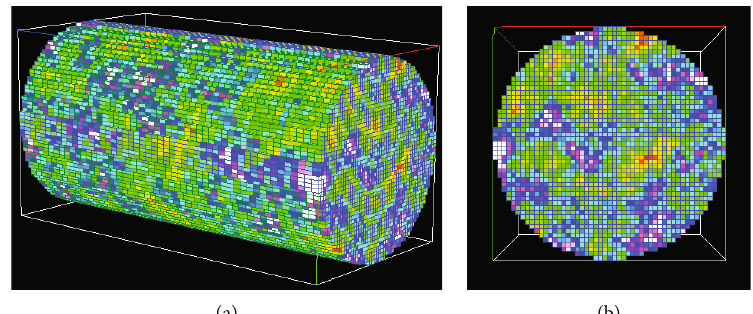
Figure 6: Numerical simulation of cores from di ff erent perspectives. (a) Numerical simulation of core under head-up view. (b) Numerical simulation of the core under the top view.